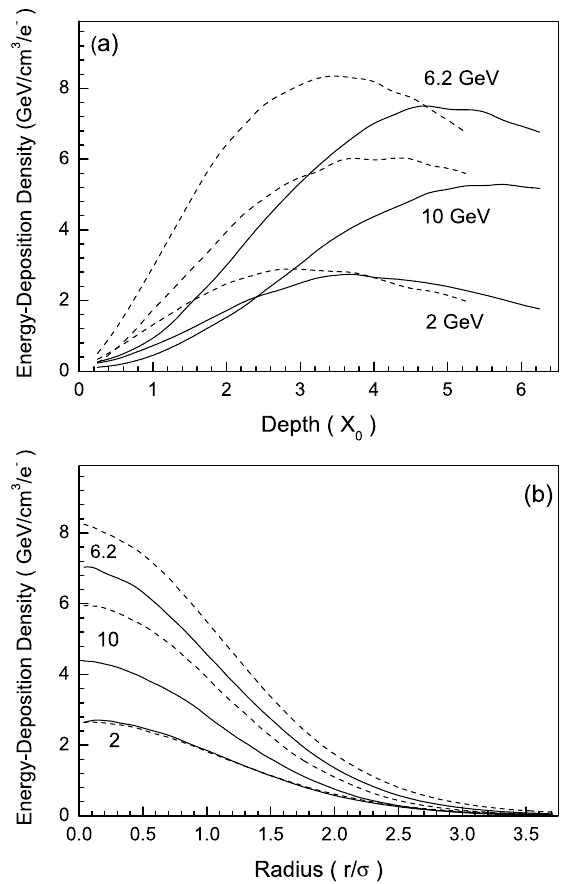
FIG. 5. (a) Energy-deposition density in the internal cylinder, versus the depth, at indicated initial energies; (b) transverse distribution of the energy-deposition density at z (cid:9) 4 : 0 X Solid lines are for amorphous and dashed lines for crystal targets.